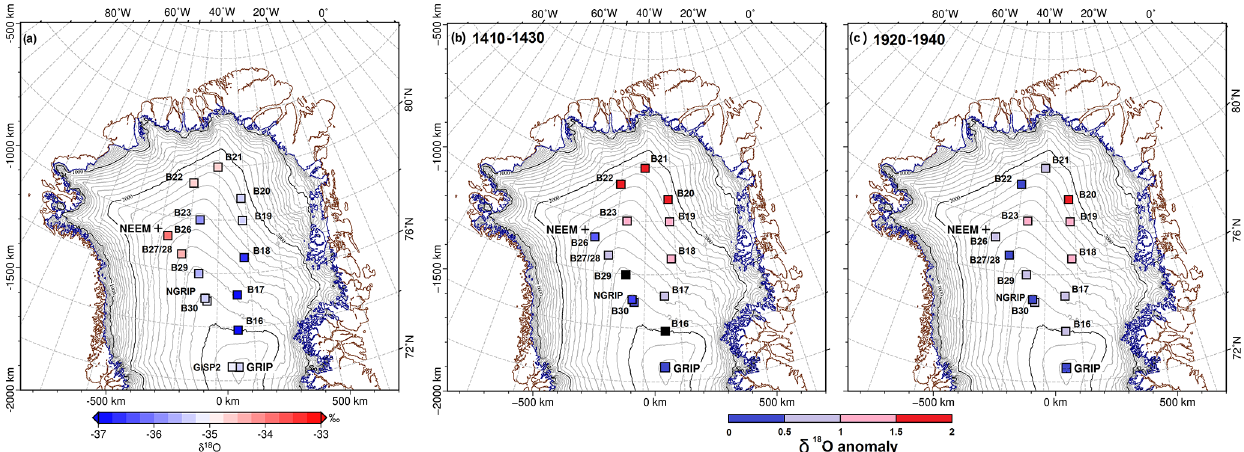
Figure 3. Spatial distribution of δ 18 O values in northern Greenland. (a) The mean δ 18 O values of the northern Greenland ice cores in their common time frame (AD1505–1953) are shown with color-coded squares. Blue colors represent lower values and red colors higher values. Mapped mean anomalies of δ 18 O compared to (a) for two different periods: (b) AD1410–1430 and (c) AD1920–1940. If a record does not cover the required time period the square is filled in